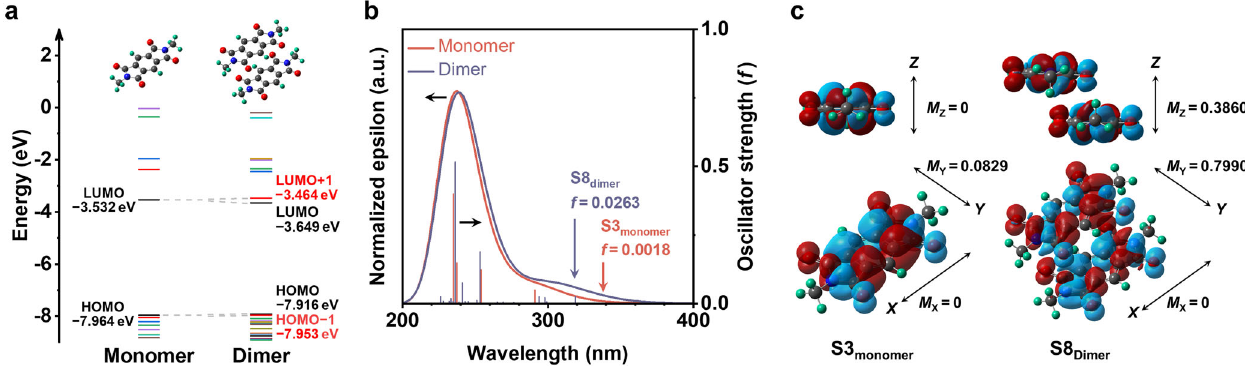
Fig. 3 DFT calculation of N , N ’ -dimethyl pyromellitic diimide as a model molecule for the polyimide. a Energy levels of the monomer and dimer. b UV – vis spectra calculated based on TD-DFT formalism. c Spatial distributions of the monomer (S3 monomer ) and dimer (S8 dimer ) transition densities. M X , M y , and M z represent the cartesian components of the transition dipole